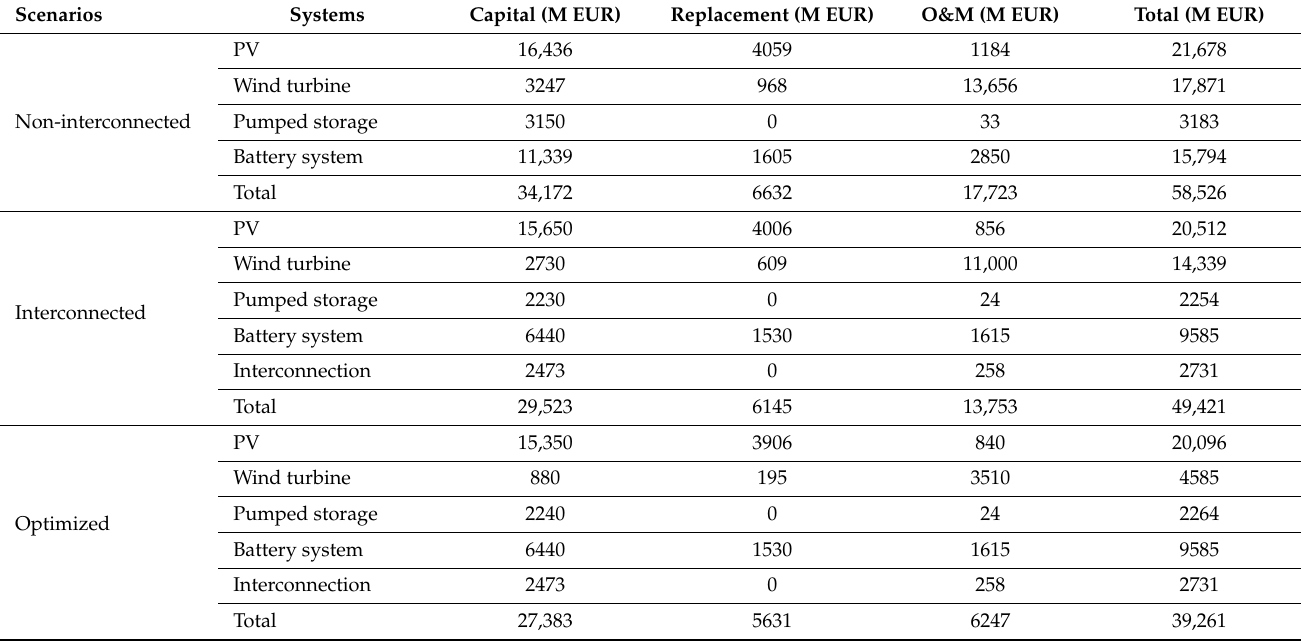
Table 15. Initial capital, replacement, O&M, and total discounted costs for the three generation